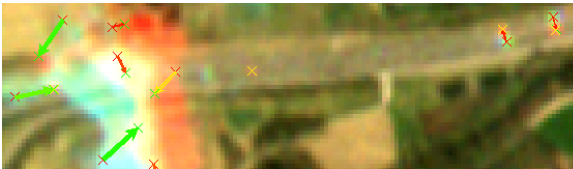
Figure 23: Typical errors in a RapidEye Scene, left on border: correctly detected car at cloud-border, left: erroneous detections in clouds, center: (single yellow cross) missed car due to bad contrast, right: wrong correlation of cars on opposite lanes